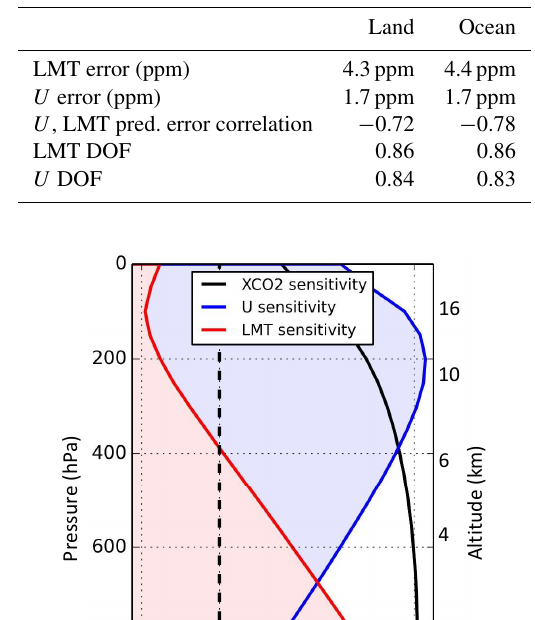
Table 2. Predicted errors and degrees of freedom for LMT and U . As seen in Table 3, the predicted errors are much larger than the actual errors.